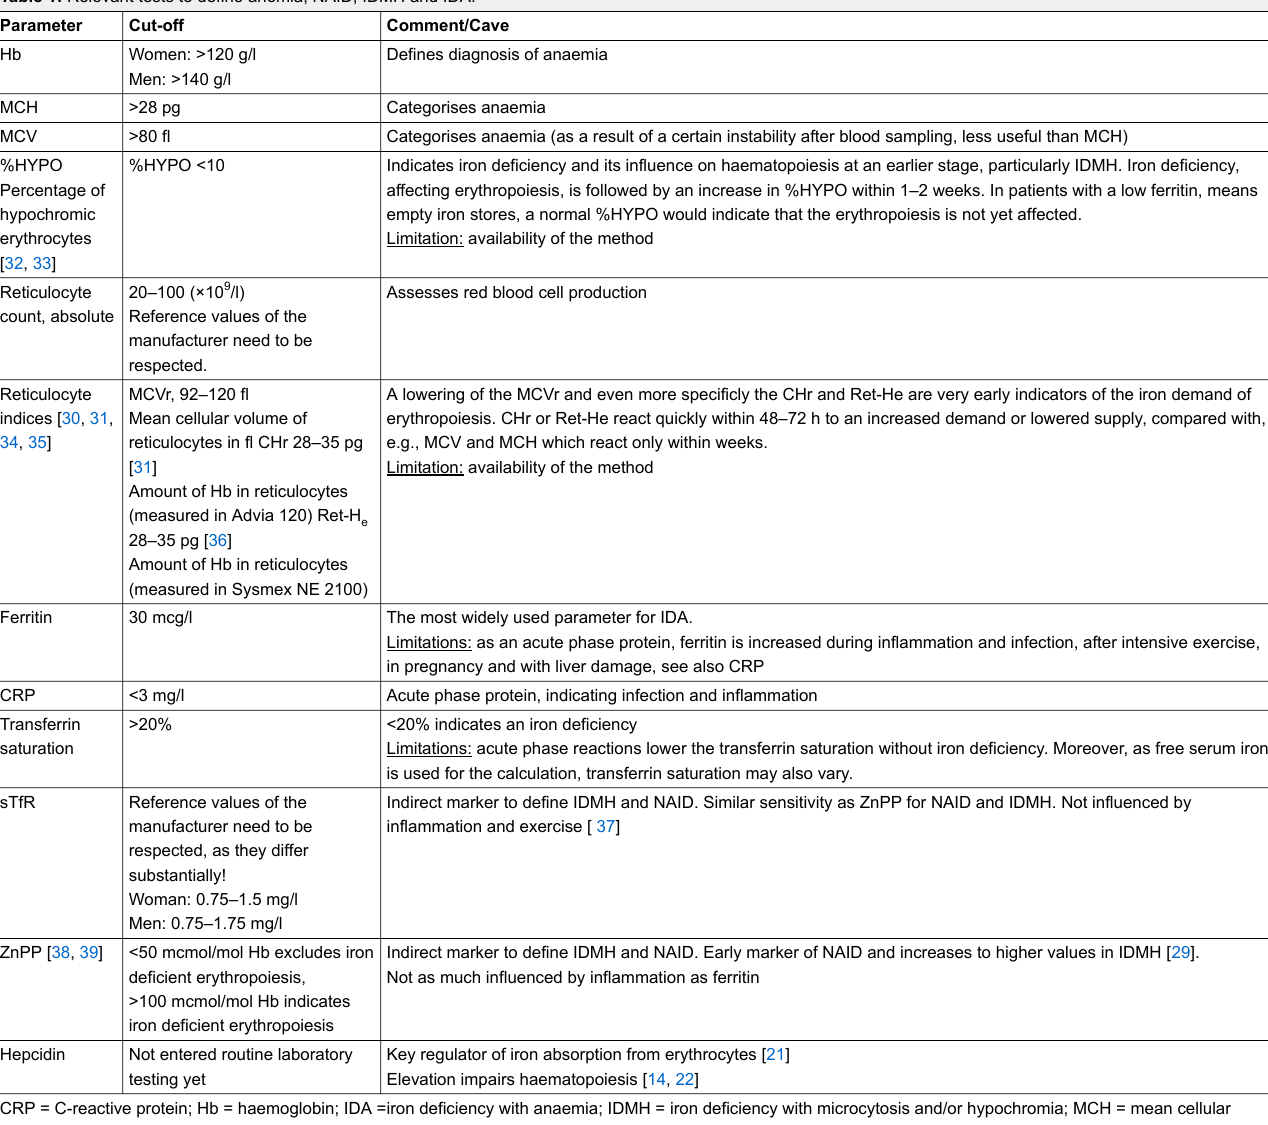
Table 1: Relevant tests to define anemia, NAID, IDMH and IDA.